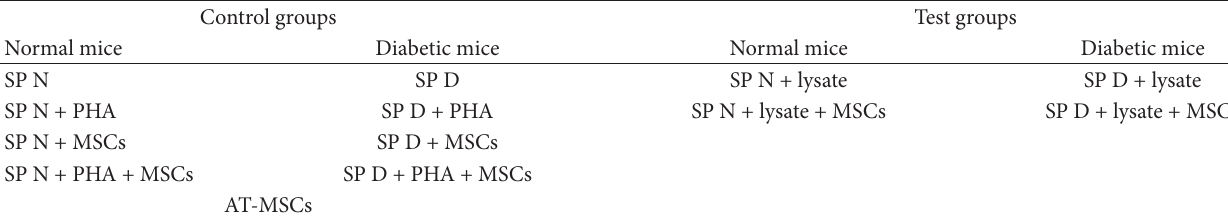
Table 1: Test and control groups in coculture